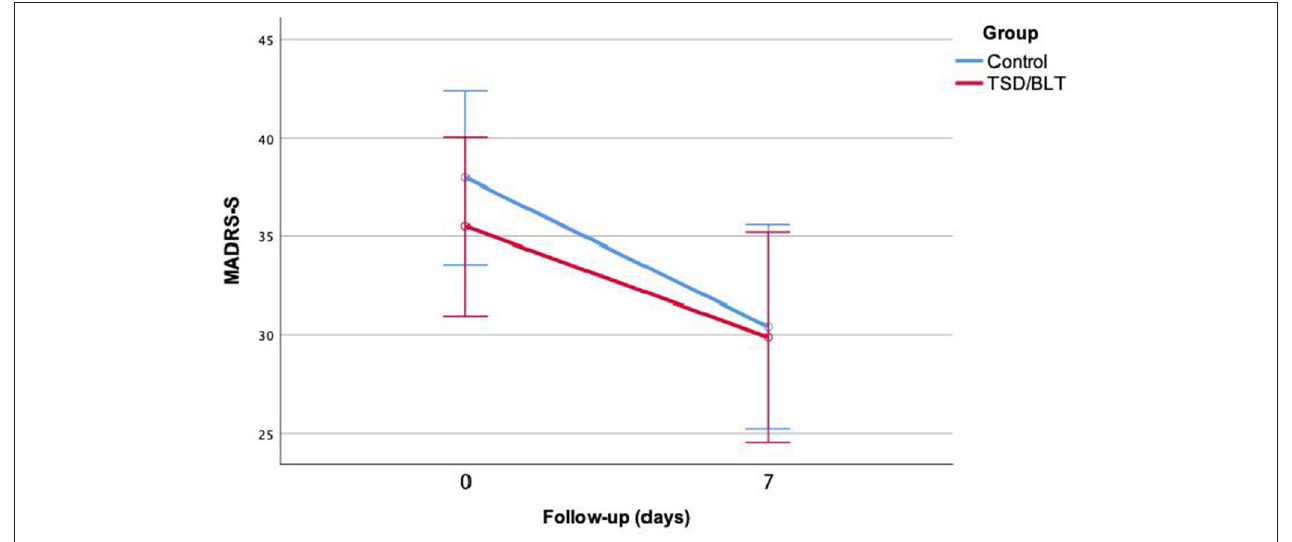
FIGURE 2 | Estimated mean (95% confidence interval) MADRS-S score in the TSD/BLT and control groups before and after